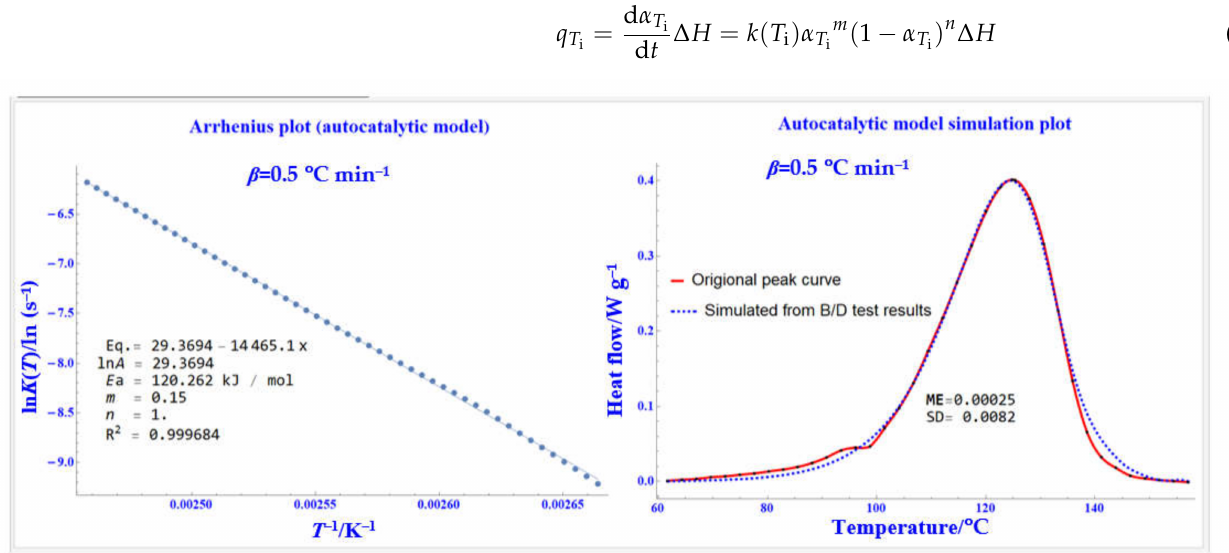
Figure 6. The Arrhenius plot showed on the left side was derived by the autocatalytic model method, the right side was the real-time dynamic simulation curve which the curve was plotted by fit-ting the derived kinetic parameters into the DSC measurement records { T , α